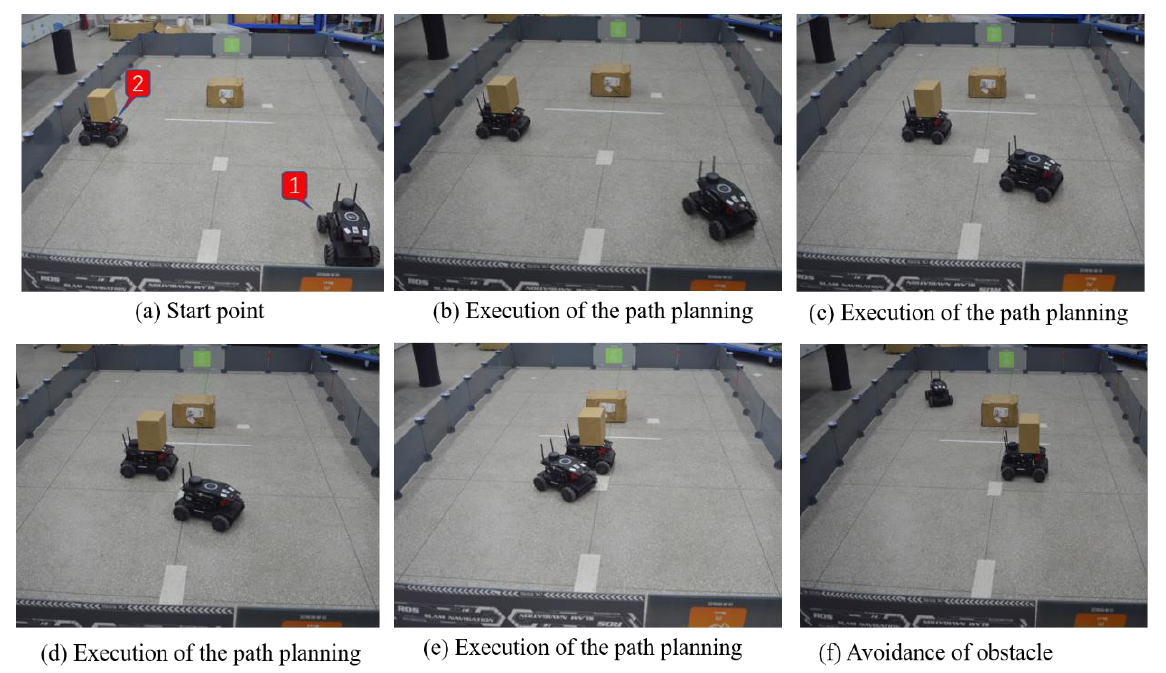
Figure 13. Experiment of avoidance of a dynamic obstacle of APF-IRRT* algorithm in a real scenario.